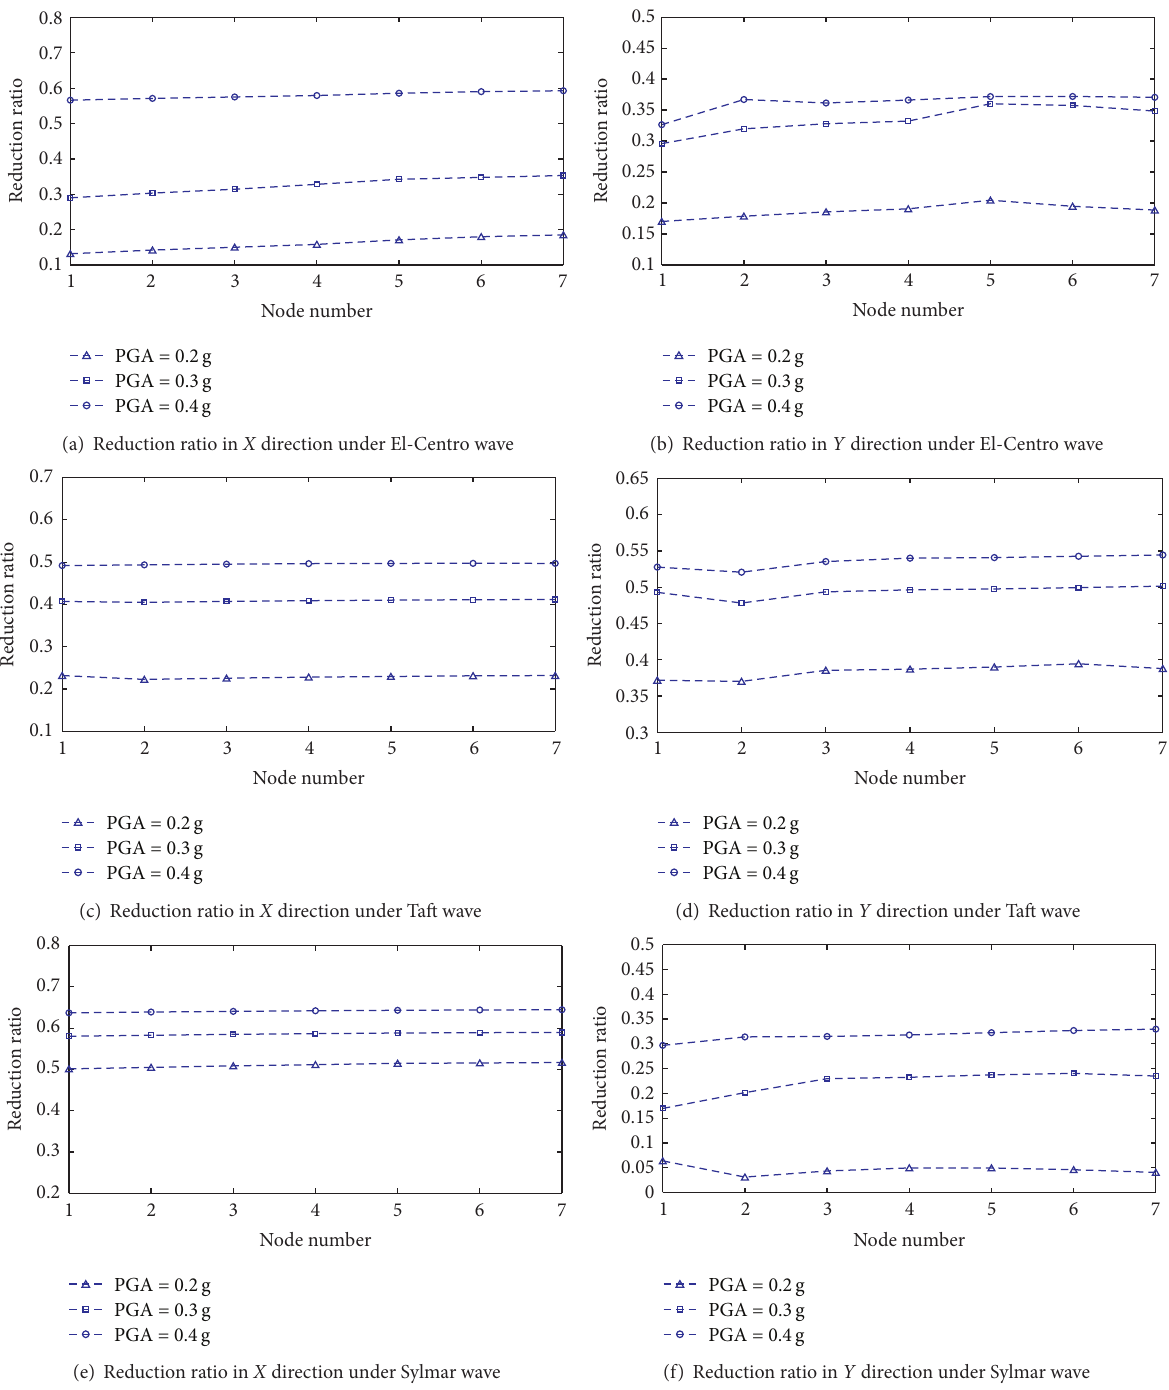
Figure 11: Reduction ratio for peak value of nodal acceleration under various earthquake